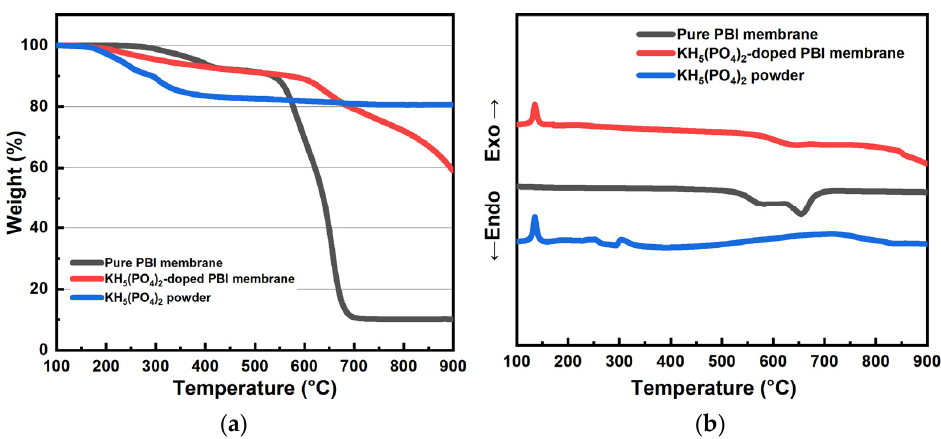
Figure 4. TGA curves ( a ) and DSC curves ( b ) of the PBI membrane, KH 5 (PO 4 ) 2 -doped PBI membrane, and KH 5 (PO 4 ) 2 powder.